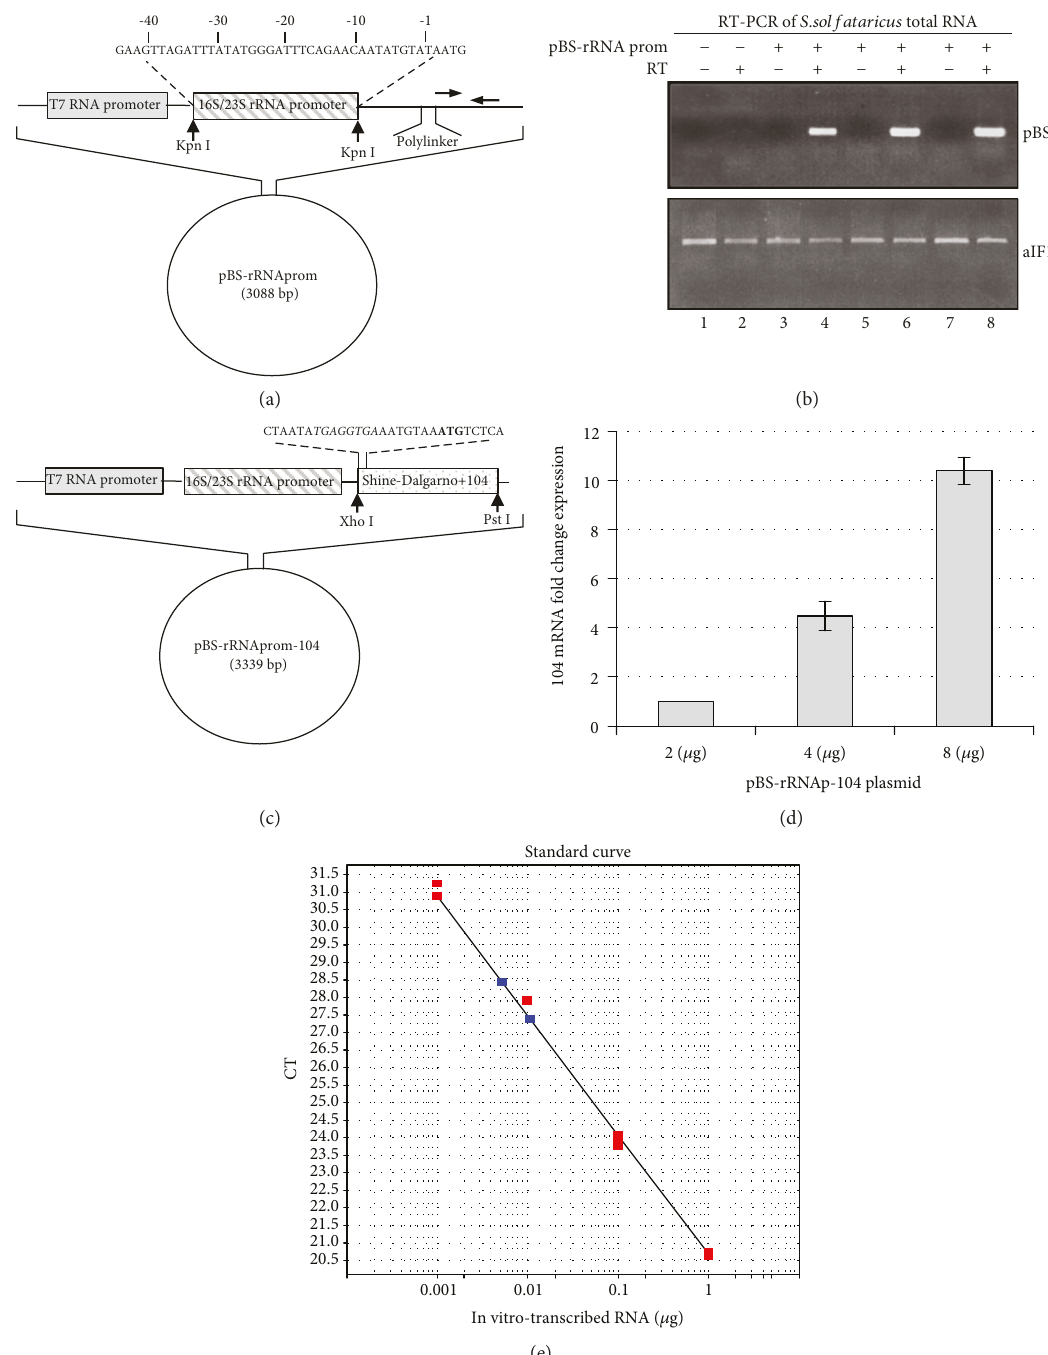
Figure 2: In vitro transcription of plasmids containing the 16S/23S rRNA promoter. (a) Schematic representation of the pBS-rRNA construct. Horizontal arrows indicate the position of primers used for RT-PCR analysis. (b) RT-PCR on total RNA extracted from S30 of plasmid and corresponding, respectively, to the lanes 4, 6 and 8 of S. solfataricus previously incubated with 2, 4 and 8 μ g of pBS-rRNA p the image. The product of the reaction is shown by the ampli fi ed fragment of 346bp. Also shown is the RT-PCR of an mRNA encoding the translation factor aIF1A, used as an endogenous control to normalize the reactions. (c) Schematic representation of the pBS-rRNA -104 plasmid. The SD motif is evidenced in italic, while the start codon is shown in bold. (d) Relative amount of RNA p transcribed by the pBS-rRNA -104 plasmid incubated into S. solfataricus S30 extract at 70 ° C for 1 h. (e) Absolute quanti fi cation of the p -104 transcript using the standard curve method. The absolute quantities of the standards were obtained measuring the pBS-rRNA p concentration of T7 in vitro-transcribed pBS-rRNA -104 RNA. Serial dilutions of the in vitro transcript were obtained and their Ct values p (red dots) were compared to those unknown (blue dots) extrapolating the amount of copies